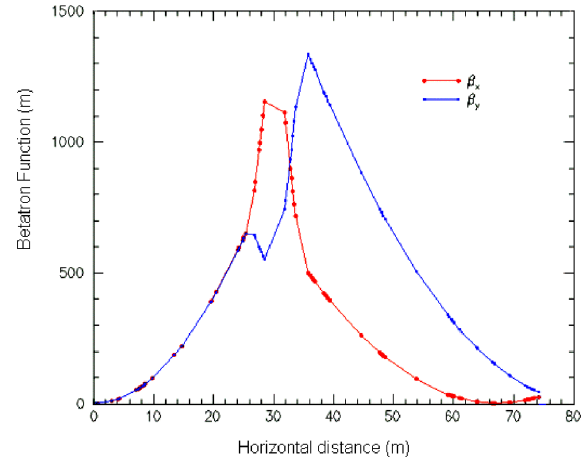
FIG. 13. (Color) The horizontal ( (cid:15) betatron functions starting at one of the collision points where the (cid:15) function is 1 m. The warm section where antigrazing rings may be installed extends from the 38 m point to 74